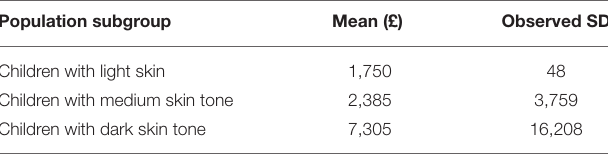
TABLE 6 | Rickets management costs by population subgroup (observational dataset; 2016–2017 year price equivalent). Population subgroup